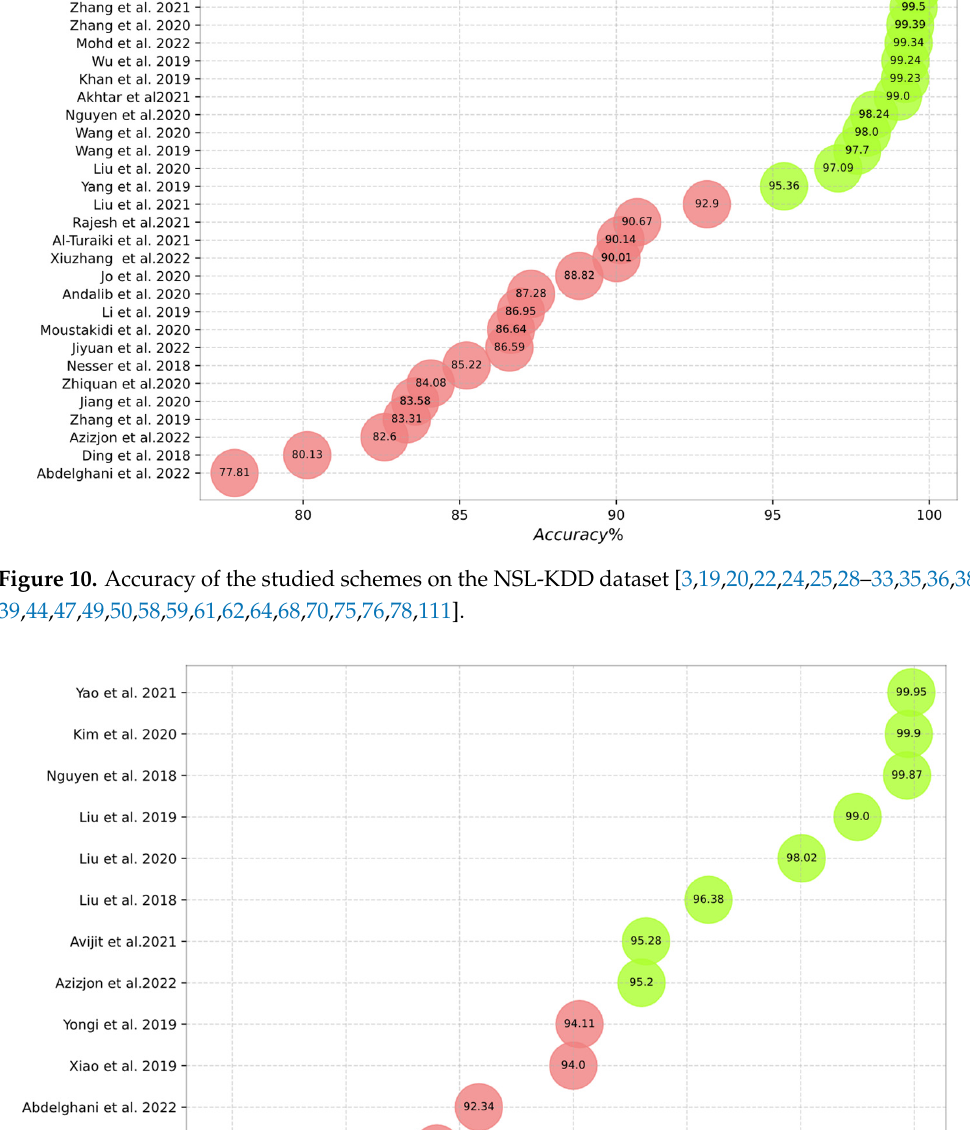
Figure 12. Accuracy of the studied schemes on the CIC-IDS 2017 dataset [15,18,41,44– 46,48,52,66,68,71,73,76].